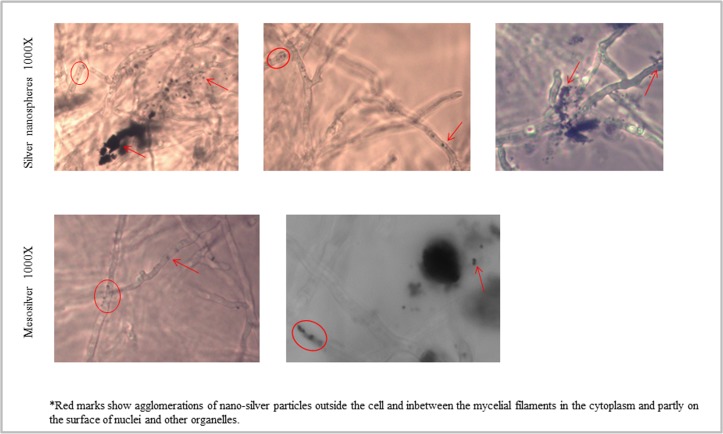
Microscopical examination of P. verrucosum; grown with 5 nm NanoComposix silver nanospheres or MesoSilver with 0.65 nm.Incubation was for 7 days at 25°C under rotation of 230 rpm. Magnification was 1000x using oil-immersion. Red marks show agglomerations of silver nanoparticles outside the cell and within the mycelial filaments in the cytoplasm and partly on the surface of nuclei and other organelles.